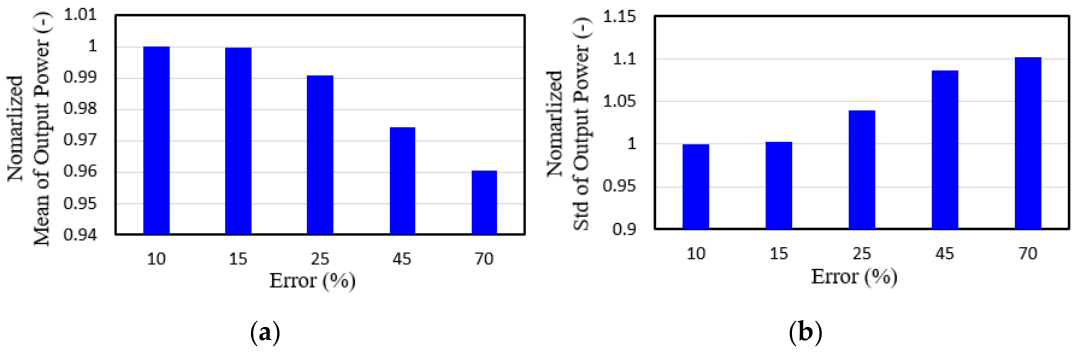
Figure 15. Histogram of PV results: ( a ) PV output voltage and ( b ) system-tracking efficiency.